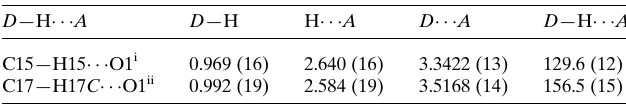
Table 3 Hydrogen-bond geometry (A˚ , (cid:2) ) for 2 .